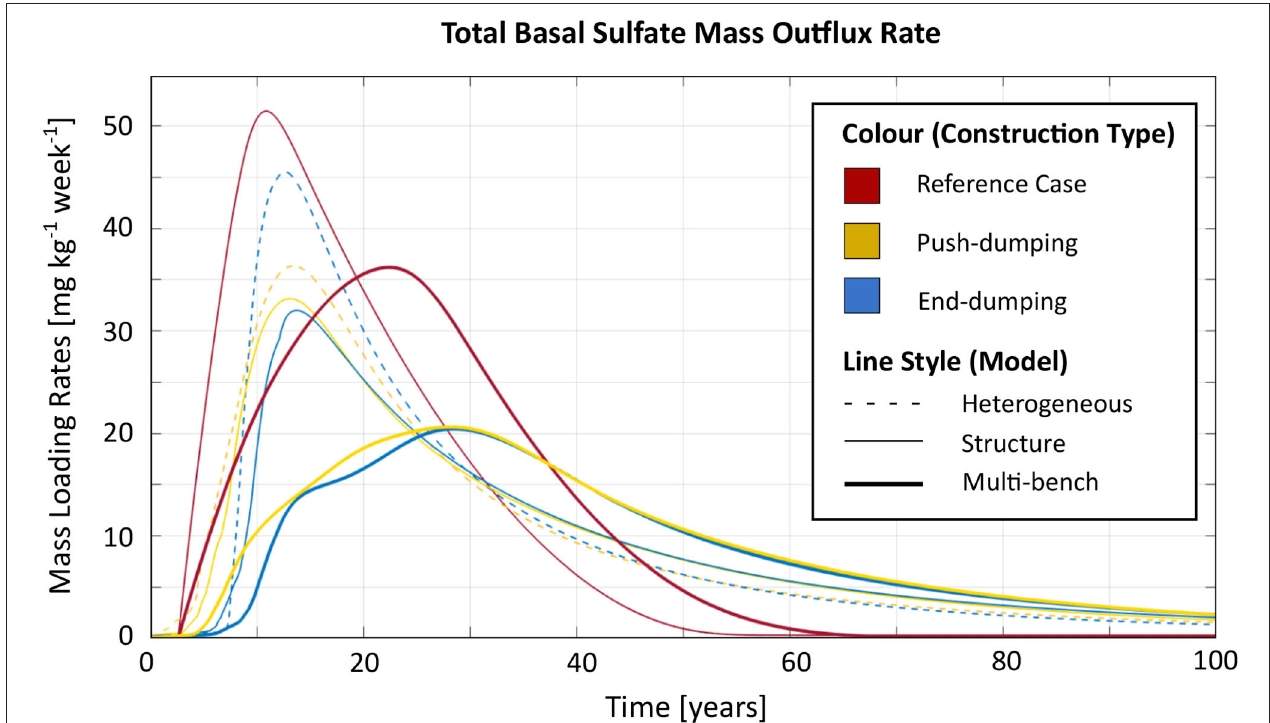
FIGURE 7 | Sulfate basal drainage evolutions shown for varied pile structure and scale. Results for total sulfate mass loading rates are normalized per kilogram of waste rock are shown for different scenarios illustrated in Figure 4 . As the pile becomes more complex through the addition of traffic surfaces and internal structural trends, differences between push- and end-dumping construction are